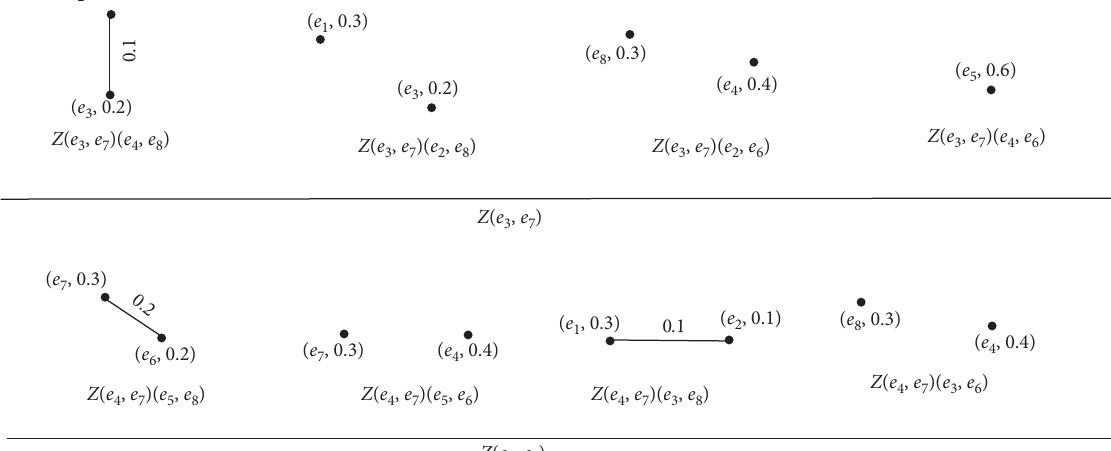
, e ) , Z ( e , e )) 3 7 4 7